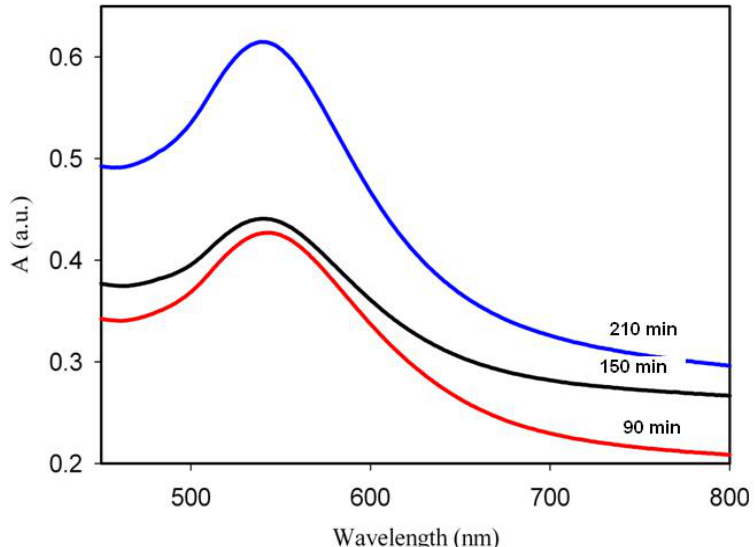
Figure 2. UV-Vis absorbance spectra of Au-PMMA nanocomposites corresponding to different irradiation times (sample annealed for 30 min at 90 °C).